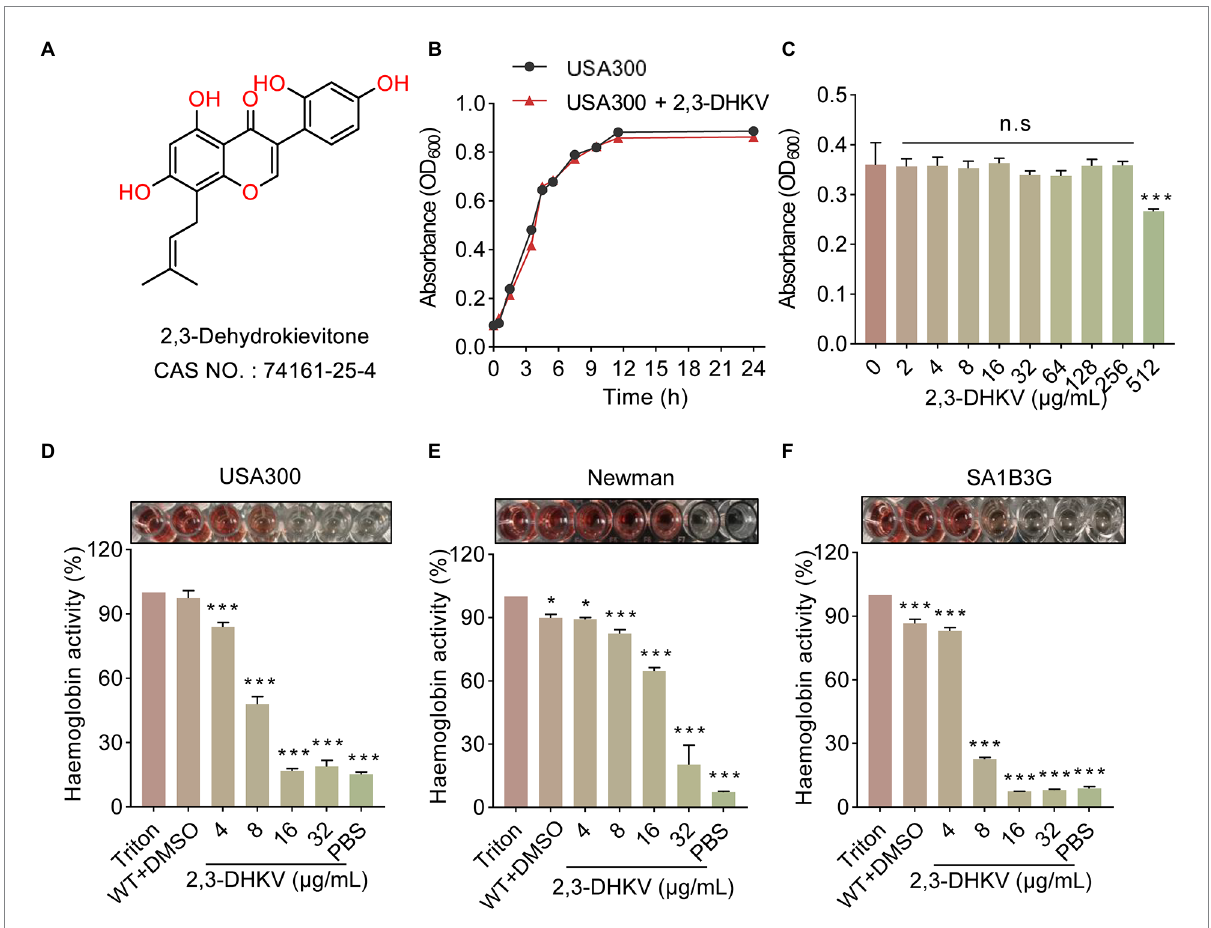
FIGURE 1 2,3-DHKV inhibits the hemolytic ability of S. aureus without affecting bacterial growth. (A) Chemical structure of 2,3-DHKV. (B) Growth curve of USA300 with or without 64 μ g/ml 2,3-DHKV. (C) The MIC of 2,3-DHKV against USA300 by micro broth dilution assay. (D–F) The effects of 2,3-DHKV on the hemolytic activity of USA300, Newman, and SA1B3G. Triton X-100 was set as a negative control. Data are presented as mean ± SD ( n = 3), * p < 0.05, *** p <